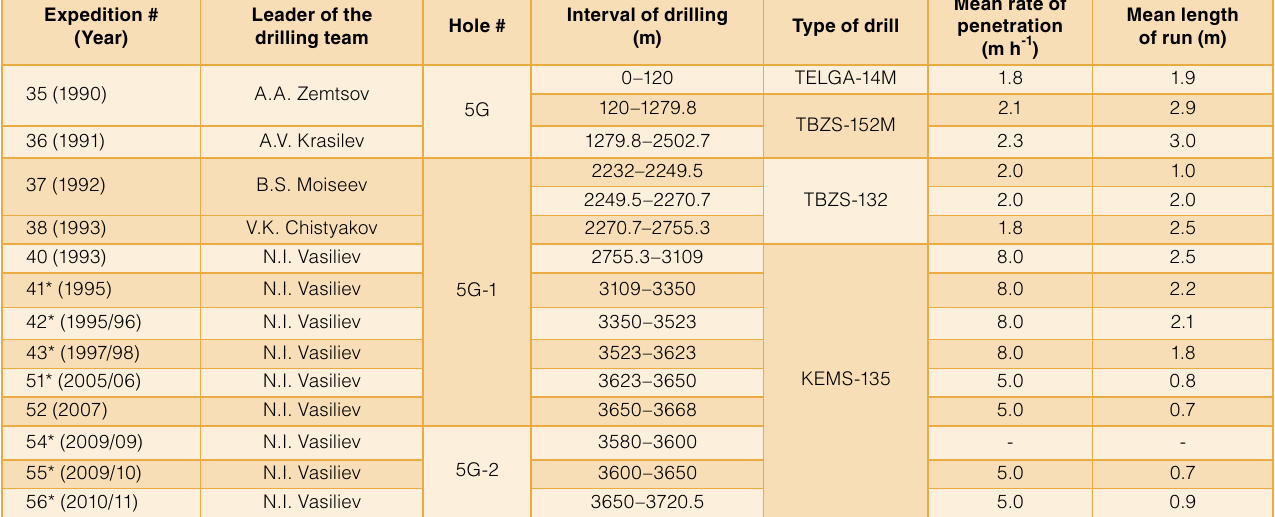
Table 1. Deep drilling of the Hole #5G (5G-1, 5G-2) at Vostok station. Expedition # (Year)